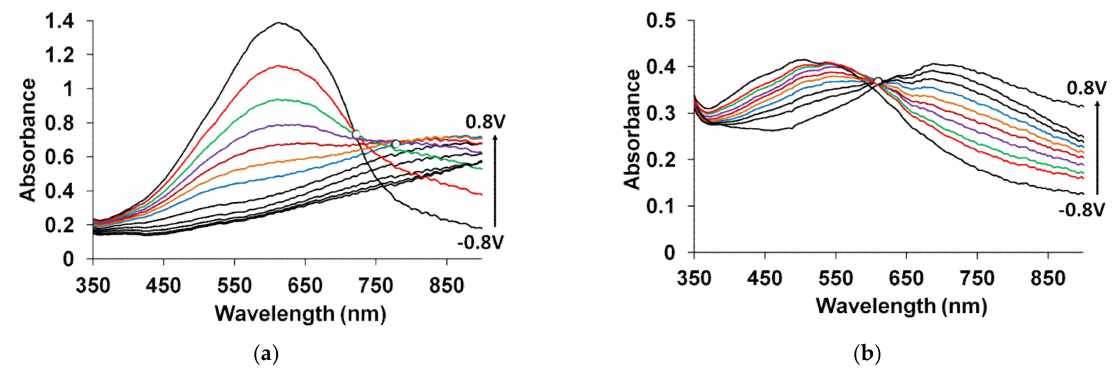
Figure 15. Optical absorption spectra of PEDOT films prepared in PAMPSA ( a ), t-PASA ( b ) measured at different potentials in 0.5 M aqueous solution of NaClO 4 .